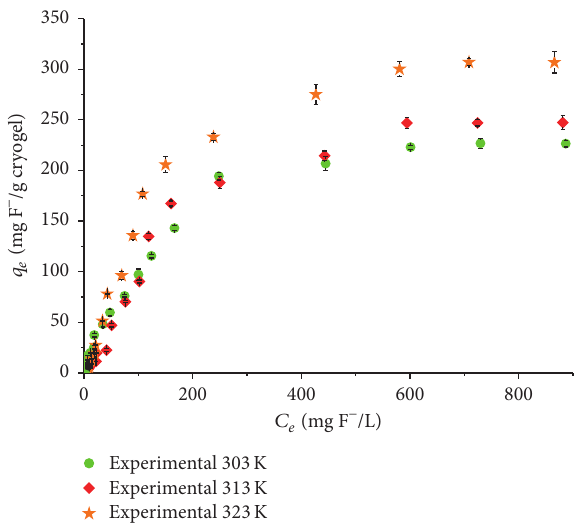
Figure 12: Sorption isotherms, cryogel QE, 8mL, 24 hours of contact, 200 rpm, 0.002 g cryogel mass, pH 6, closed atmosphere.